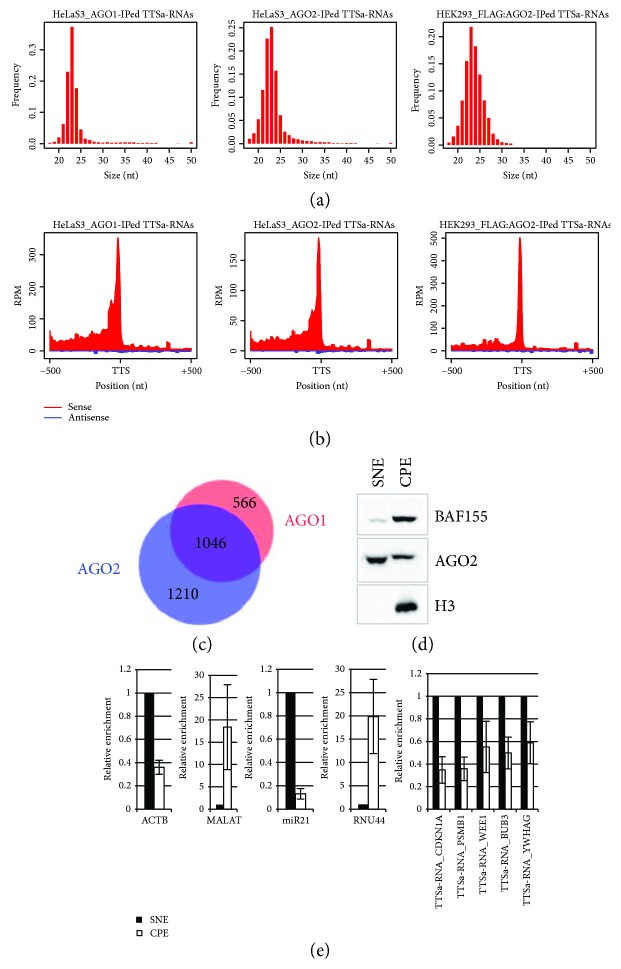
TTSa-RNAs are associated with nuclear AGO1 and AGO2. (b) Coverage of AGO1- and AGO2-immunoprecipitated TTSa-RNAs (HeLa S3) and FLAG:AGO2-immunoprecipitated TTSa-RNAs (HEK293) around GENCODE v25 annotated TTSs. Red and blue represent sRNAs in the sense and antisense orientation with respect to gene transcription, respectively. (c) Overlap of genes giving rise to AGO1- and AGO2-associated TTSa-RNAs. (d) Purified nuclei from HeLaS3 cells were extracted with a forcing urea/detergent buffer to yield a soluble nuclear extract (SNE) and chromatin pellet extract (CPE). SNE and CPE were analyzed by Western blot for the presence of chromatin-associated proteins (BAF-155 and H3) and AGO2. (e) RNA was isolated from HeLaS3 SNE and CPE and analyzed by qRT-PCR for the detection of ACTB mRNA (as a non-chromatin-associated RNA), MALAT-1 (as a chromatin-associated RNA), miR-21, RNU44, and 5 selected TTSa-RNAs (n = 3). Synthetic ath-miR159a was added to SNE and CPE fractions before RNA isolation and subsequently used for qRT-PCR normalization.